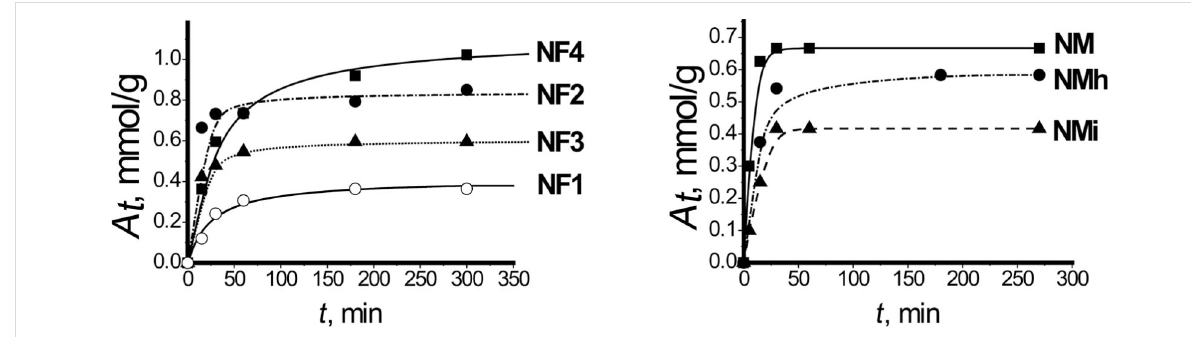
Figure 4: Pseudo-second-order kinetic curves for the sorption of copper(II) ions by the synthesized samples (the continuous lines are showing the fit of the model for each case with experimental points indicated by geometrical symbols).